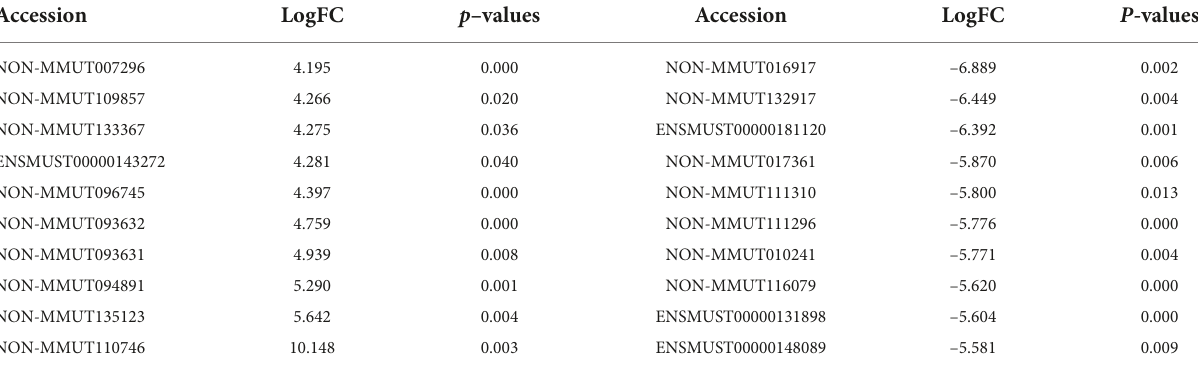
TABLE 2 The top 10 upregulated and downregulated genes of DElncRNAs.